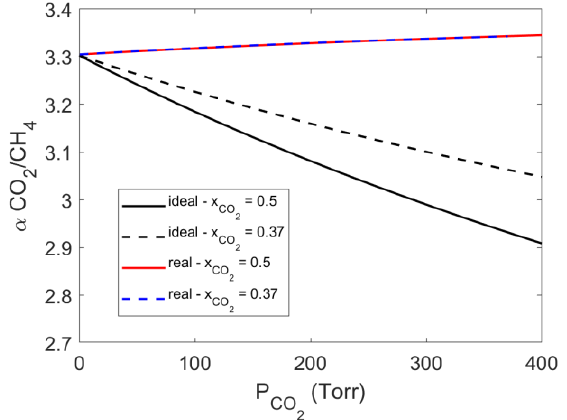
Figure 11. Comparison between ideal and real solubility selectivity as a function of carbon dioxide partial pressure and mole fraction. The solubility selectivity is calculated with the NETGP-NR model.